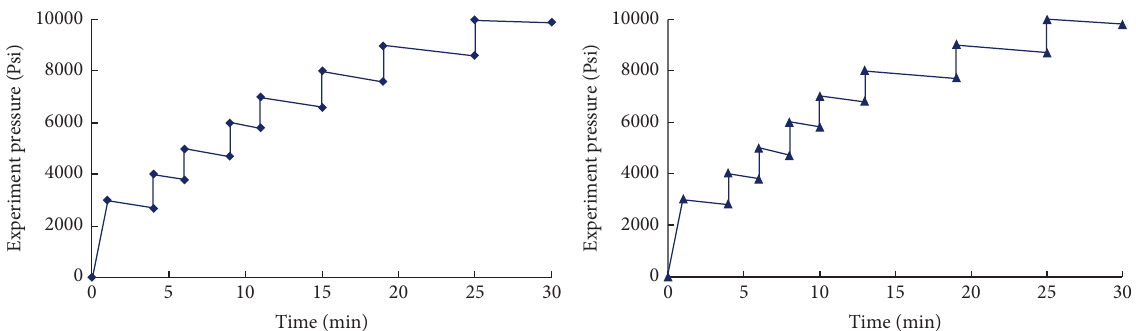
Figure 22: Pressure curves of 1# and 2# rubber cylinders.